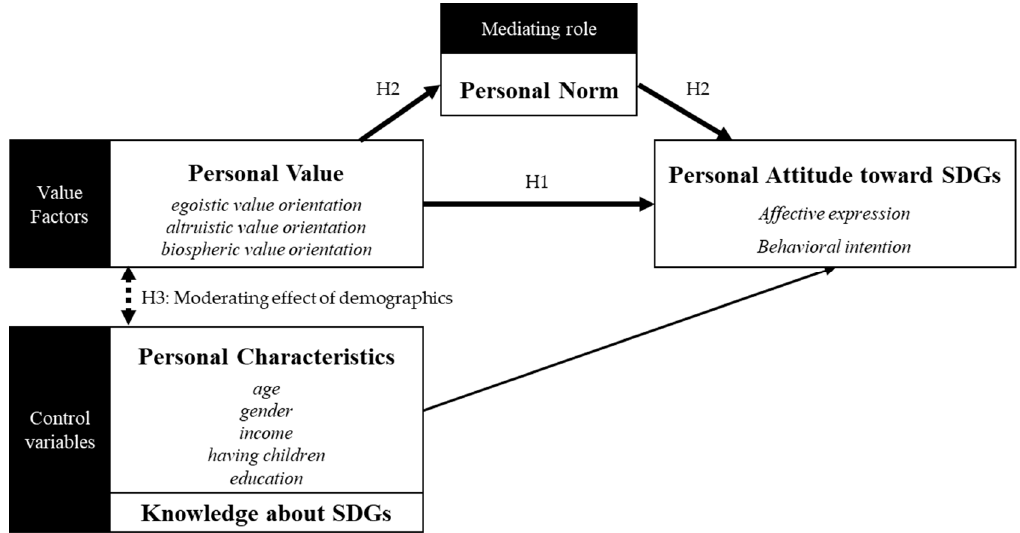
Figure 1. Personal value orientations, norms and individuals’ attitude toward SDGs.